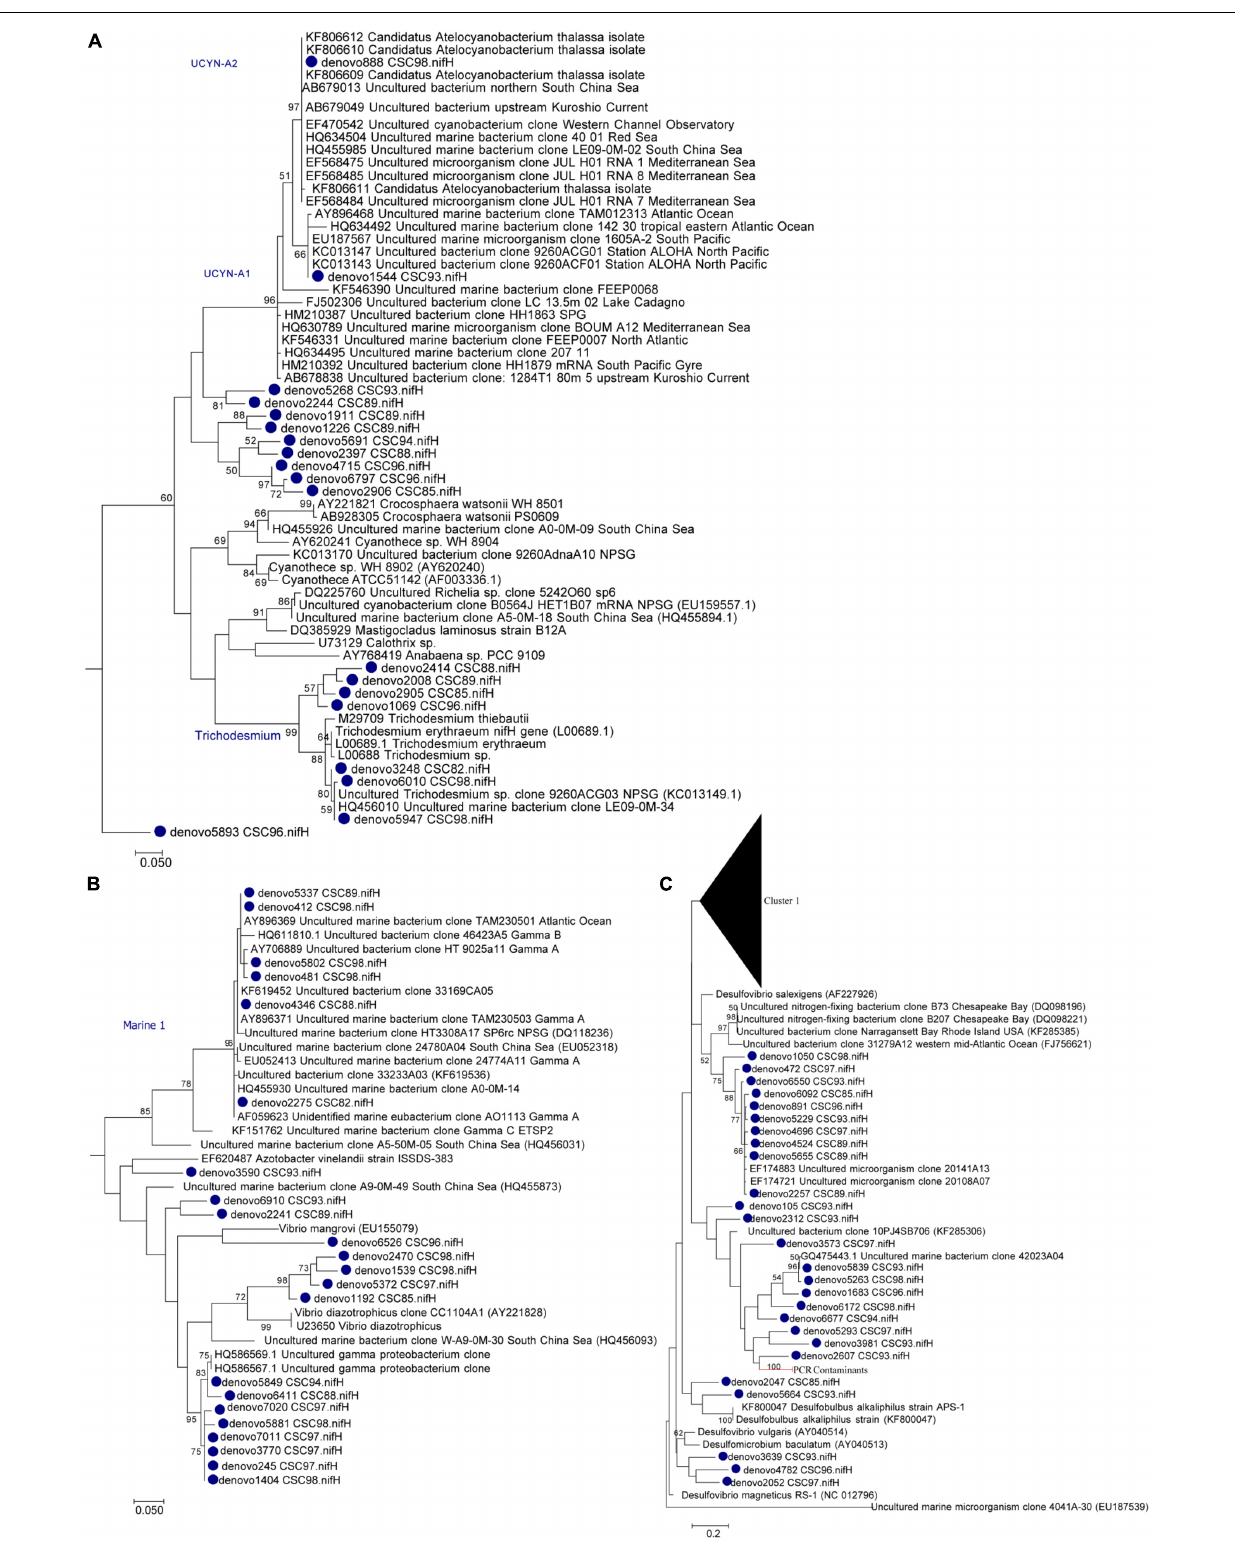
Frontiers in Microbiology |